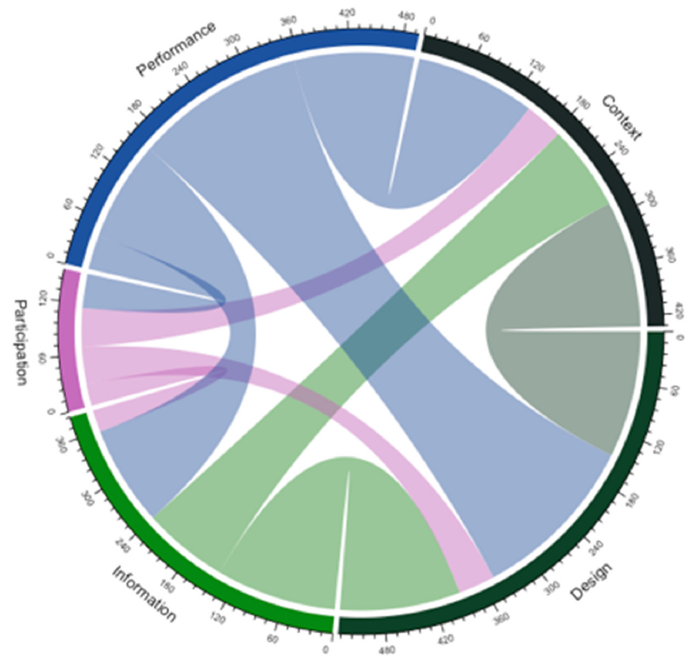
Figure 2. Intersections between the five major themes. An intersection occurs when a code belong- ing to Theme A and a code belonging to Theme B are applied to the same unit of text (here, typically paragraphs).